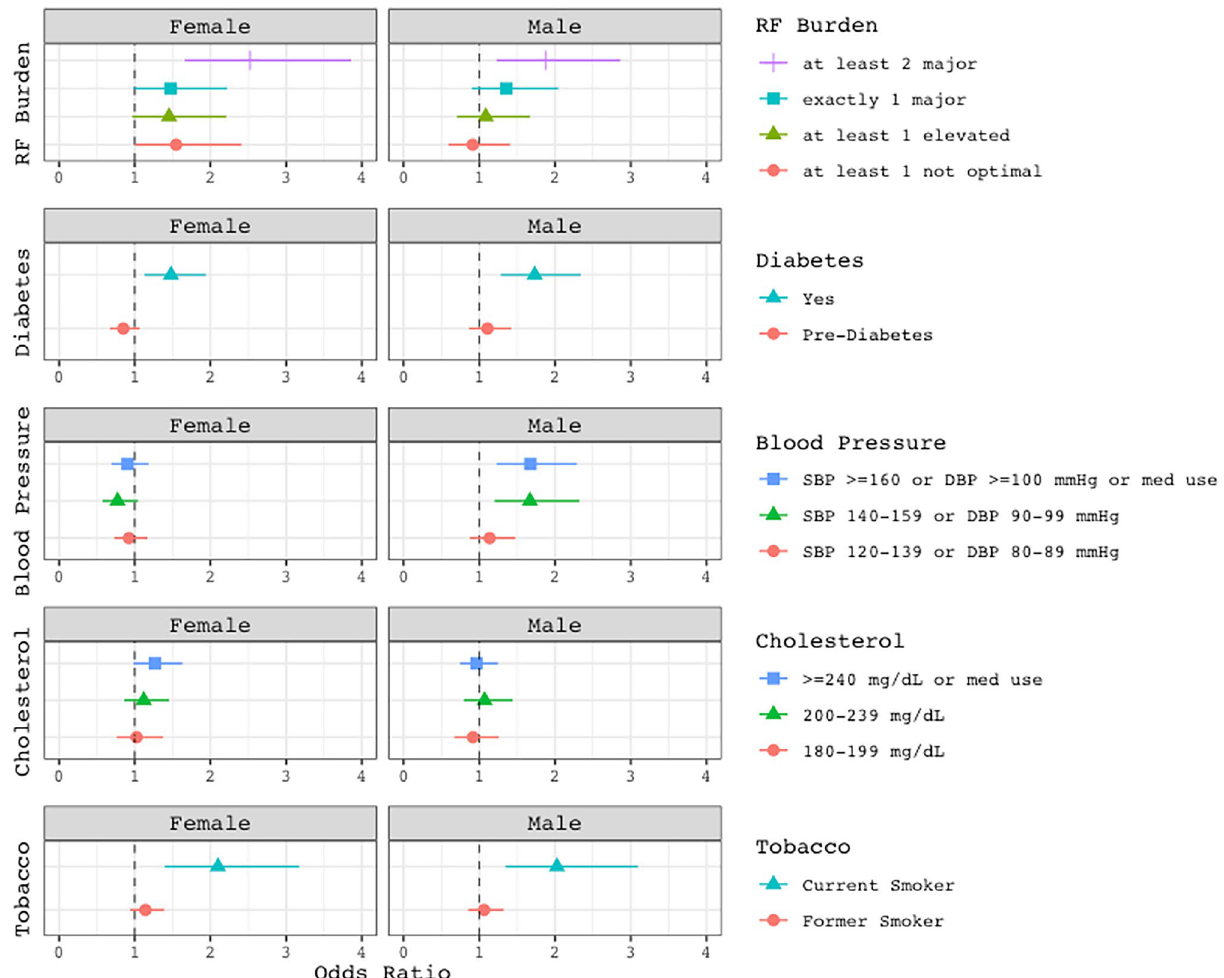
Figure 3. Sex-stratified forest plots of multivariable adjusted odds ratios * (95% CI) for hearing loss † . DBP diastolic blood pressure, RF risk factor, SBP systolic blood pressure. * Adjusted for age, noise exposure, hearing aid use, and BMI. Individual risk factors are covariates in individual risk factor models. † Defined as PTA 0.5,1,2,4 > 20 dB HL in the worse